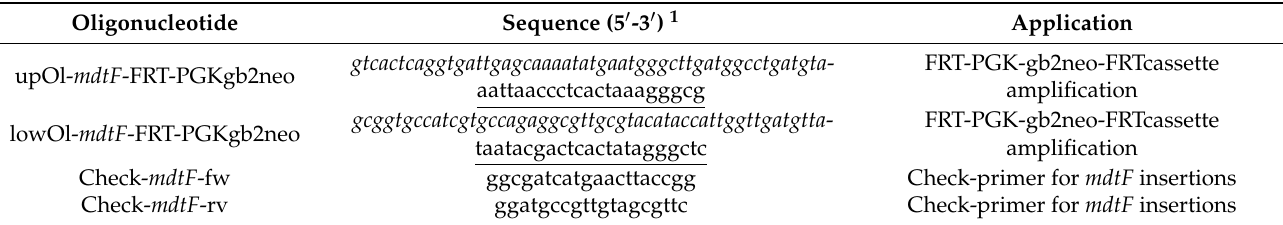
Table 2. Oligonucleotides used in this